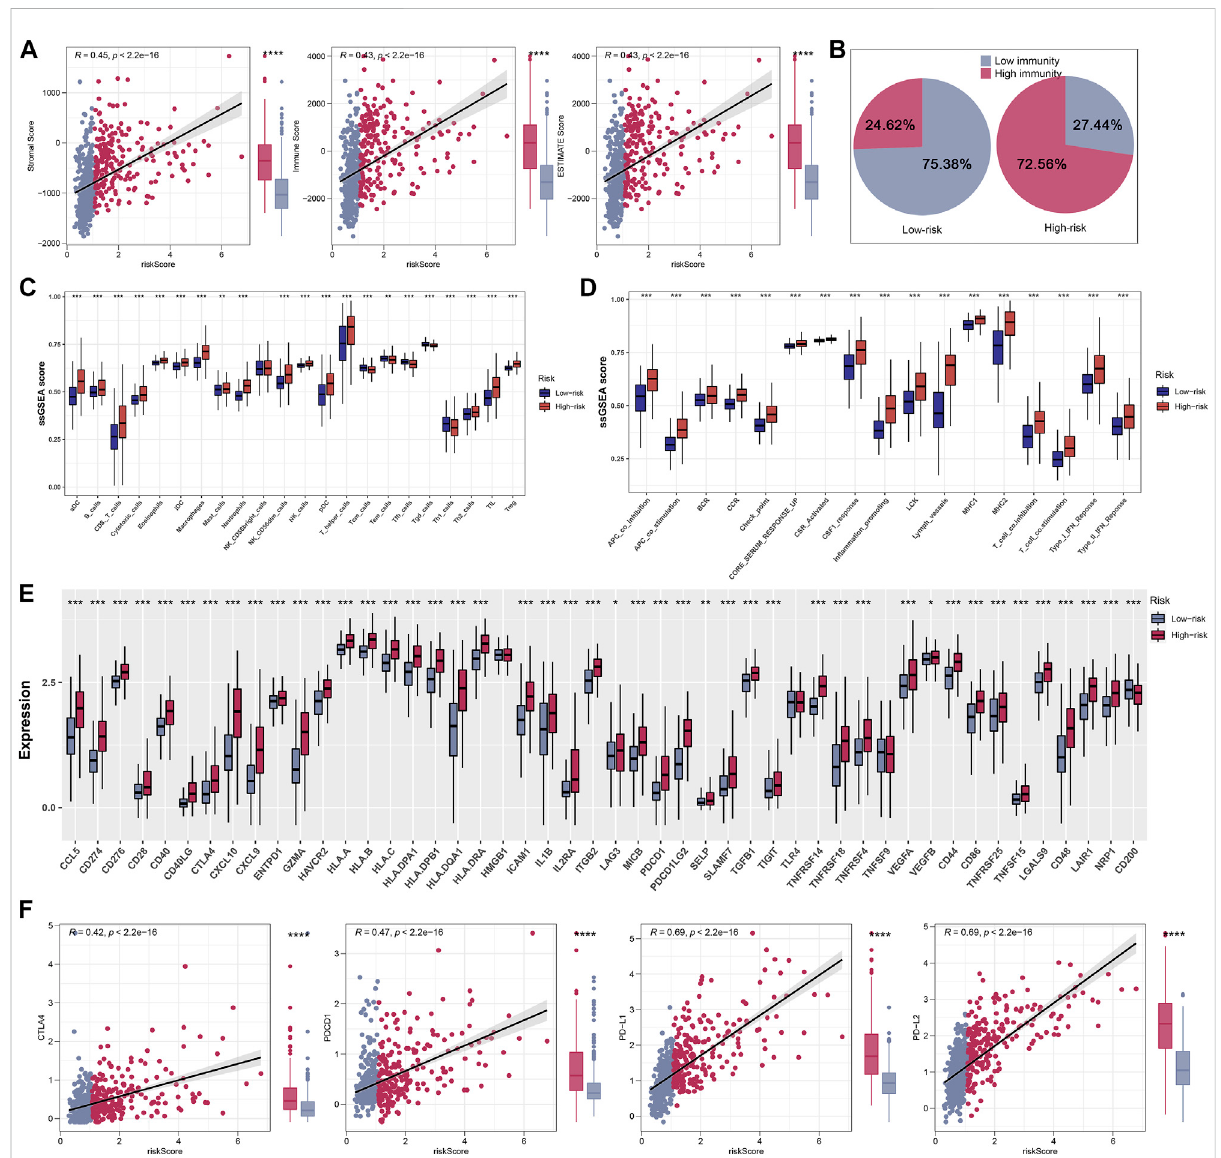
FIGURE 7 Explore differences in immune characteristics between high- and low-risk groups. (A) Differences between the three scores in the high- and low-risk groups. (B) Based on 39 immune characteristics, the high-risk group had more highly immunized patients. (C,D) Expression differences of 39 immune characteristics between high- and low-risk groups of patients with glioma. (E) Differences in expression of common immune checkpoints between high- and low-risk groups of glioma patients. (F) Correlation analysis of four immune checkpoints between high- and low-risk groups of glioma